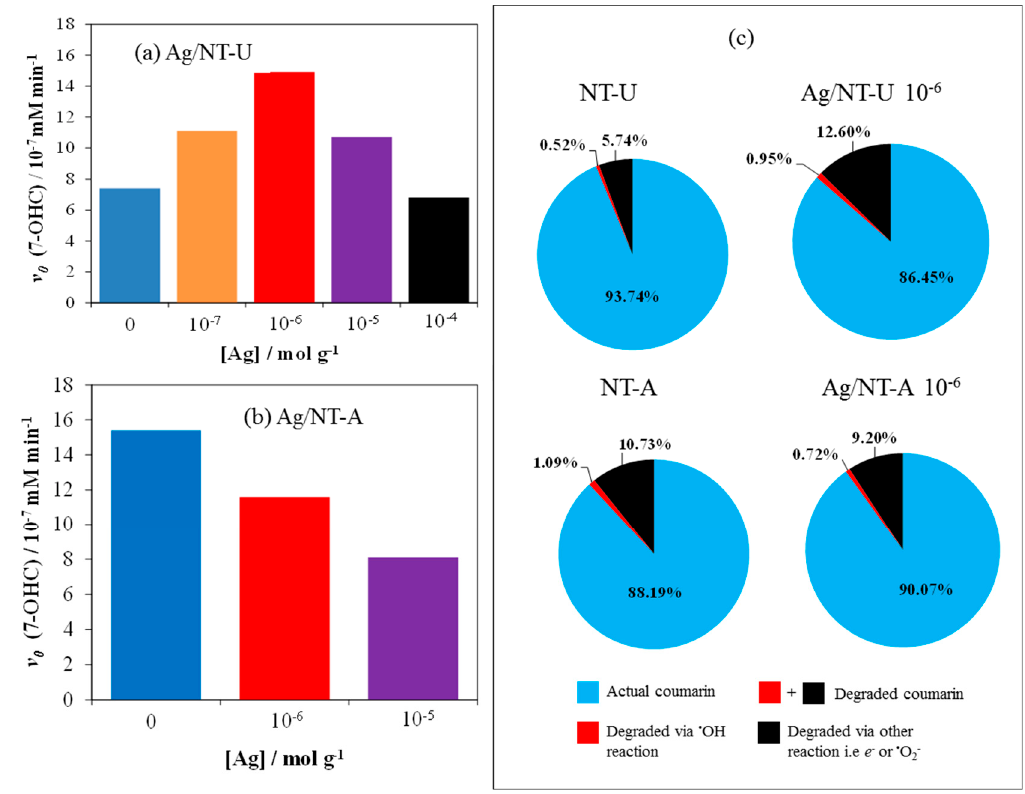
Figure 10. ( a ) Initial rate of 7-OHC formation on ( a ) Ag/NT-U and ( b ) Ag/NT-A catalysts, and ( c ) photocatalytic pathways on them after 240 min irradiation.